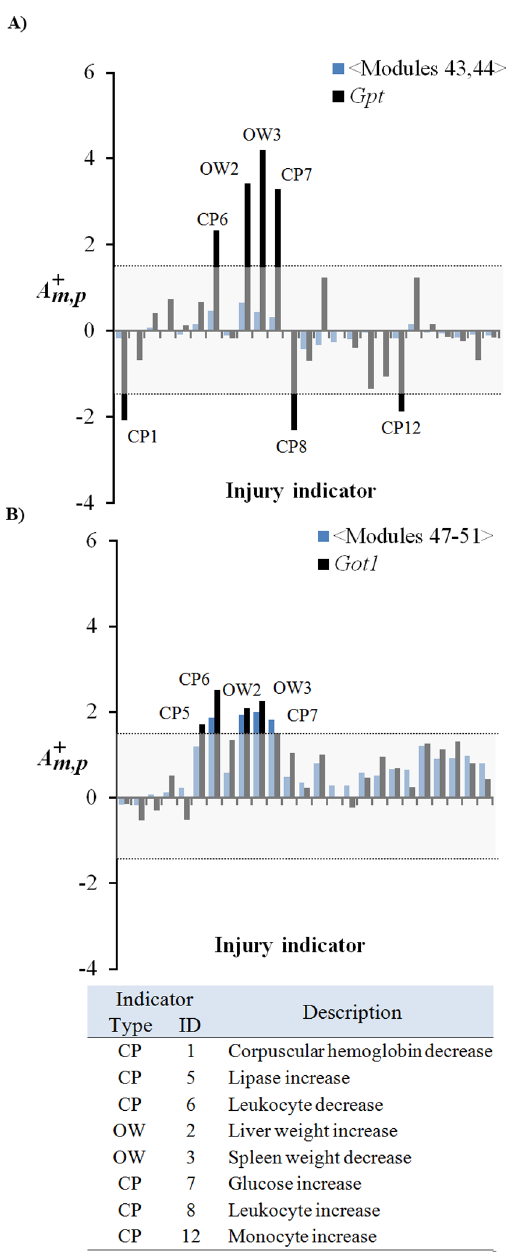
Figure 6. Activation patterns for selected modules and biomarker genes. Activation patterns shown correspond to the 25 injury indicators in Table 1 . Labeled peaks represent average module greater than 1.5 as calculated using Equation (8). activation score A z m , p A ) The top graph shows averaged activation of modules 43 and 44 compared with the gene activation pattern of alanine aminotransferase ( Gpt ). B ) The middle graph shows the average activation of modules 47 to 51 compared to the gene activation pattern of aspartate aminotransferase ( Got1 ). CP, clinical pathology; OW, organ weight.